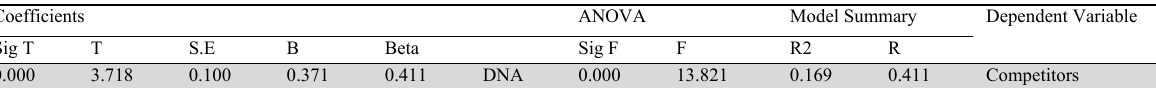
The results of the simple regression analysis for exploring the impact of the organizational DNA doesn’t on competitors in commercial banks in Madaba